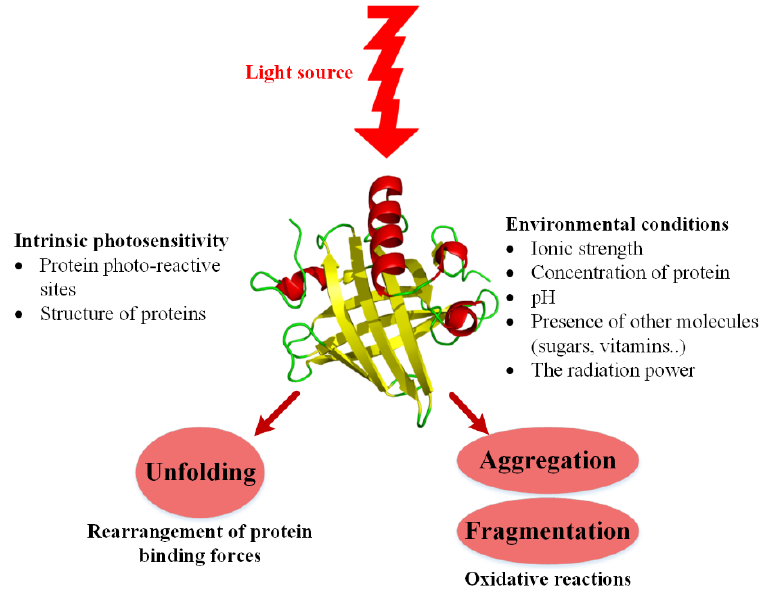
Figure 4. Determinants of photo-susceptibility of proteins (the data were extracted from [63]).